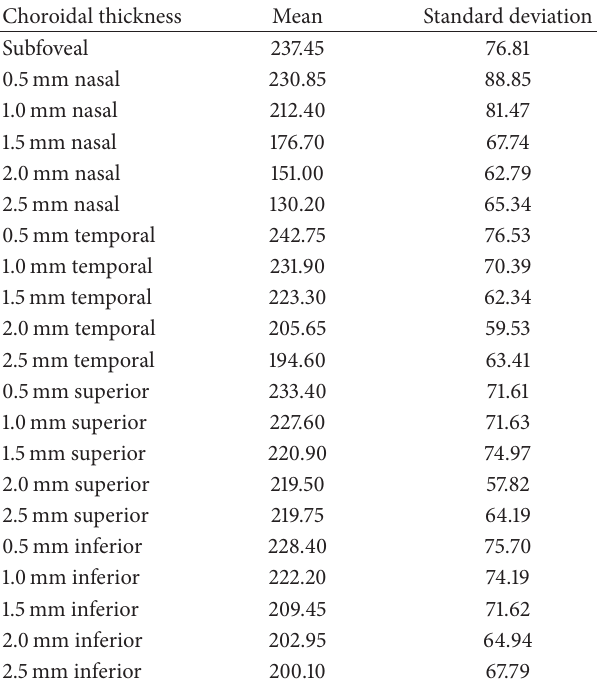
Table 3: Mean choroidal thickness values at different sites (values are in microns).